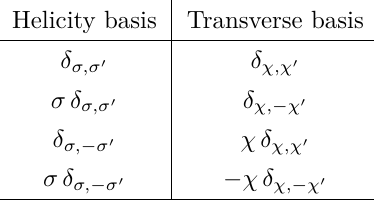
Table 1. A conversion table between the helicity and transverse spinor